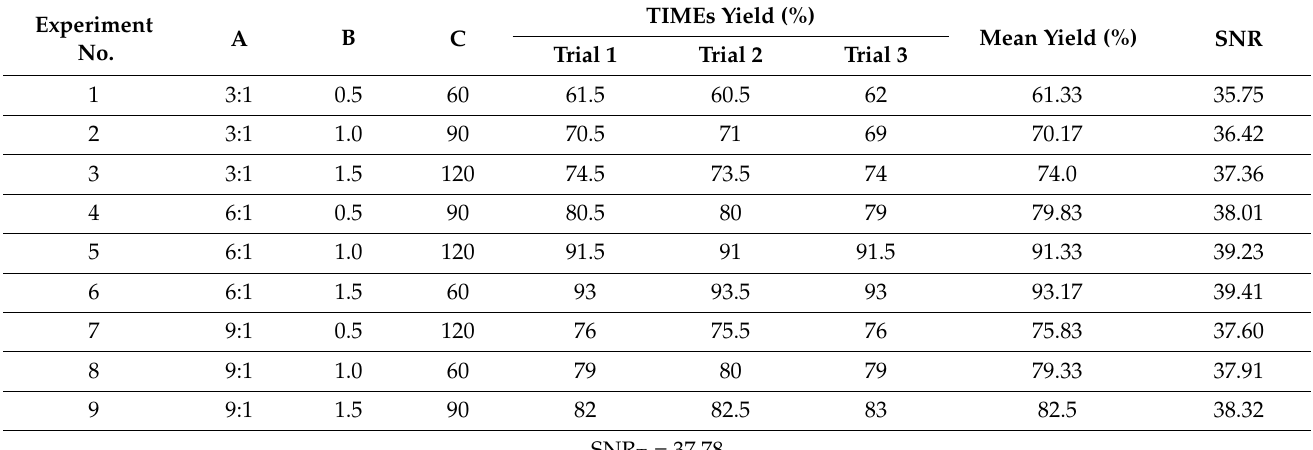
Table 5. Percentage yield of TIMEs and SNRs for the experiments designed by L 9 orthogonal array.